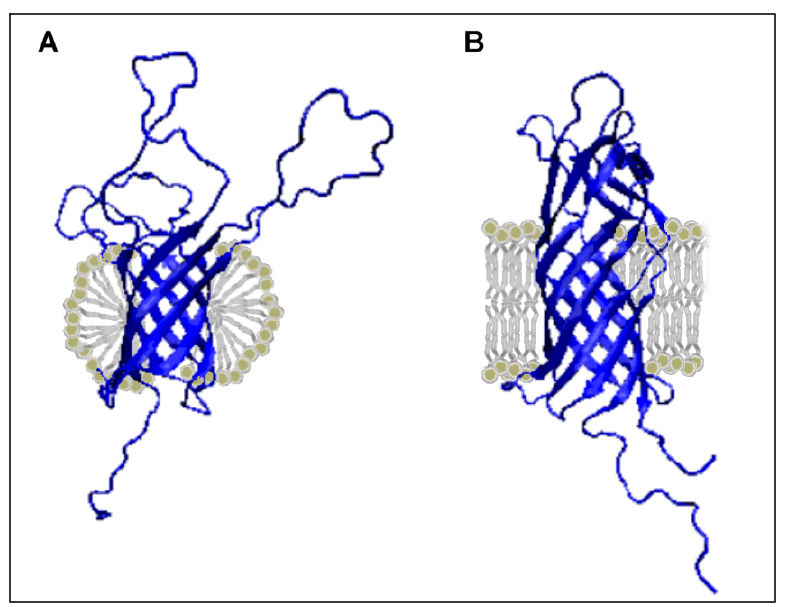
Figure 5. Comparison of the AlkL structures: ( A ) 6QAM detergent environment (gray) and ( B ) 6QWR, lipid environment (gray), according to reference [30].